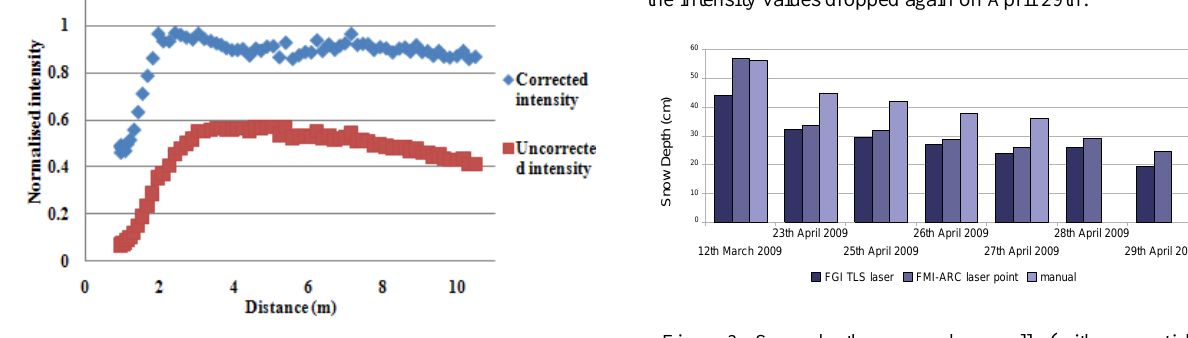
Figure 2. The effect of Z+F LaserControls distance correction on TLS intensity values (of the 99% Spectralon panel). The raw intensity values have been normalised to a scale of 0 to 1.